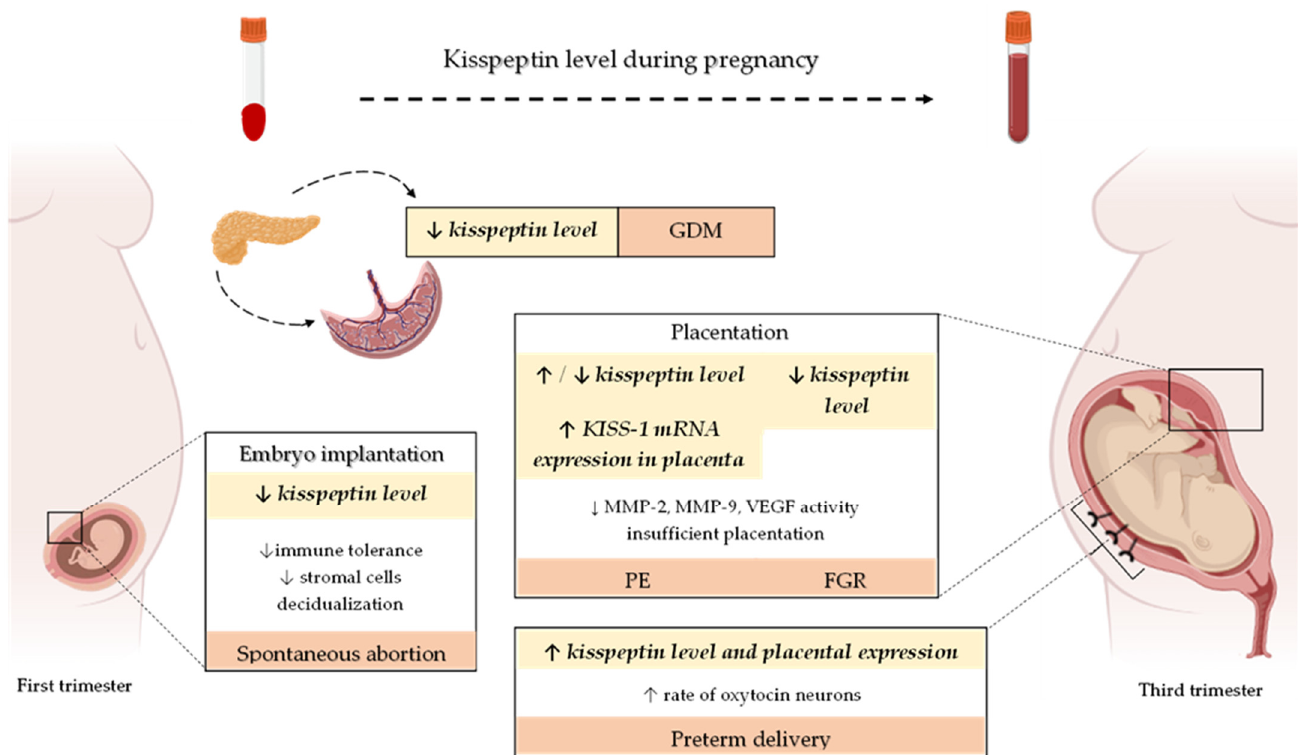
Figure 2. Changes in plasma/serum kisspeptin level and its expression in the human placenta during the physiological course of gestation as well as the most common pregnancy-related complications.